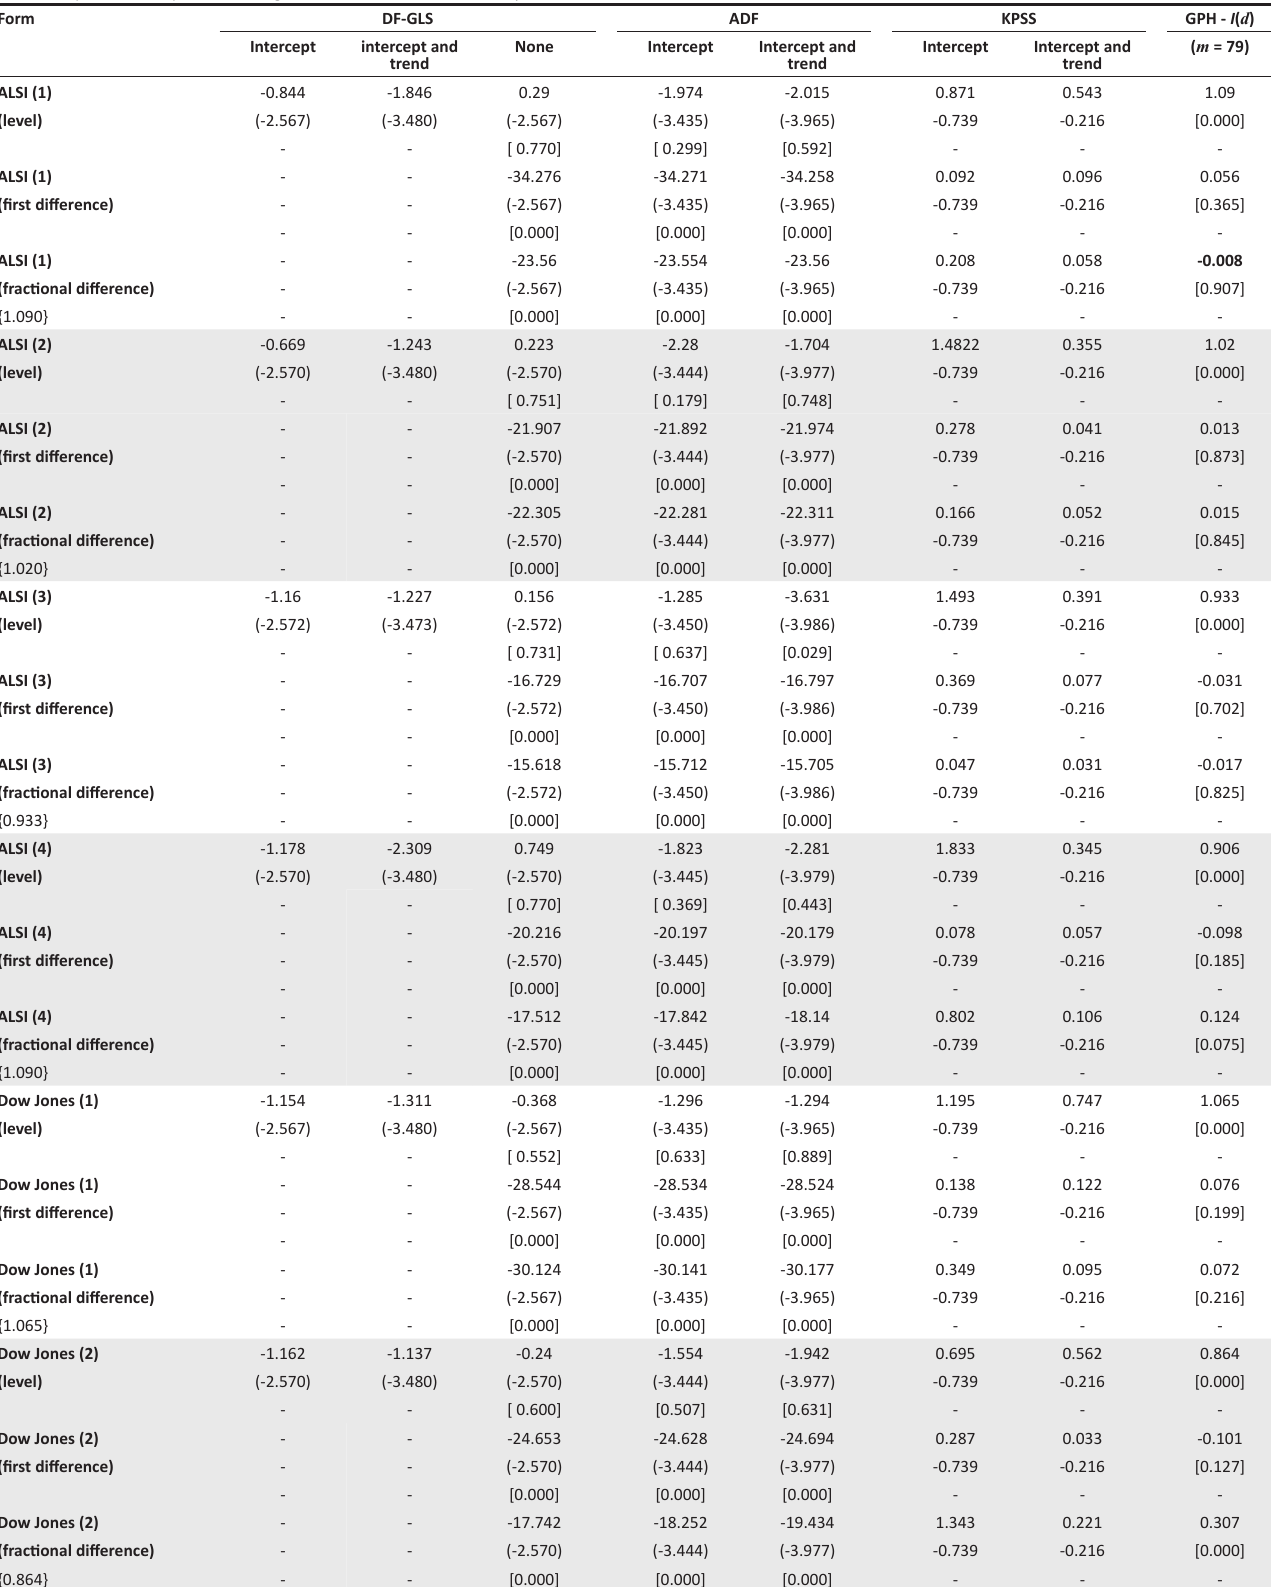
TABLE A1 (Continues...): Determining the correct form of stationarity.